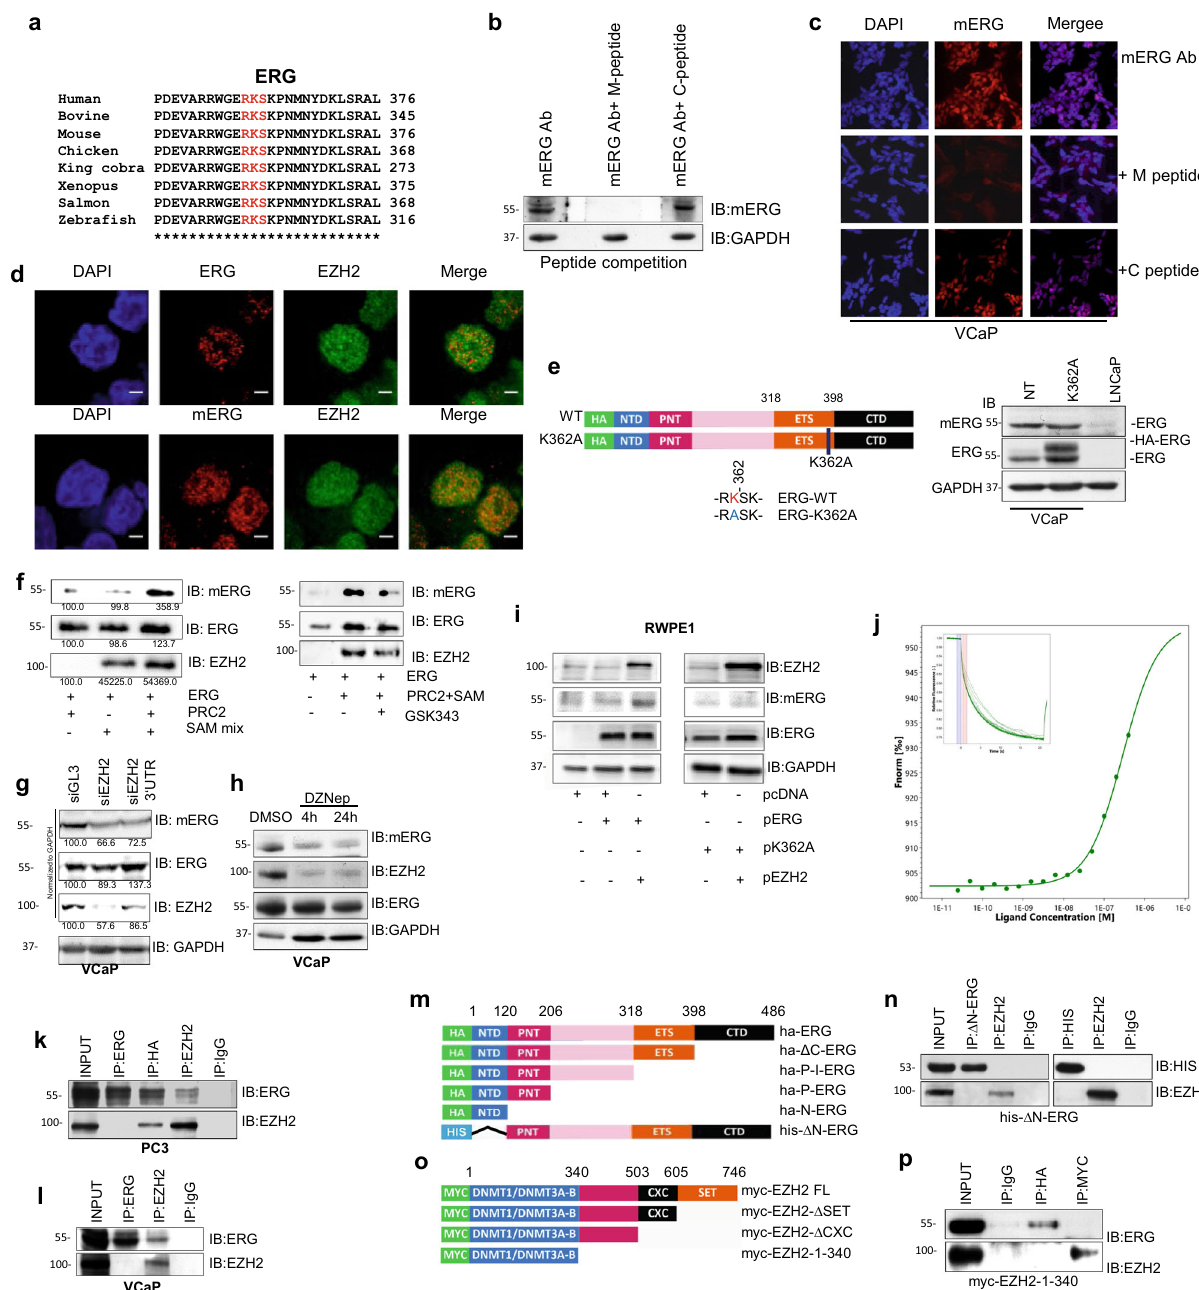
Fig. 1 EZH2 methylates ERG at lysine K362. a Sequence alignment of ERG domain containing the EZH2 recognized R-K-S motif from diverse species. b Detection of methylated ERG in VCaP cells by immunoblotting with anti-mERG antibody and competition with methylated (M) and non-methylated (C) peptides ( n = 2). c Detection of mERG in VCaP cells by immuno fl uorescence microscopy with anti-mERG antibody pre-incubated with the speci fi c competitor and control peptides ( n = 2). Scale bar = 20 µ m. d Detection of ERG, EZH2, and mERG in VCaP cells by immuno fl uorescence microscopy ( n = 2). Scale bar = 20 µ m. e Detection of ERG and mERG by IB in control and HA-tagged K362A ERG transfected VCaP cells ( n = 2). f In vitro